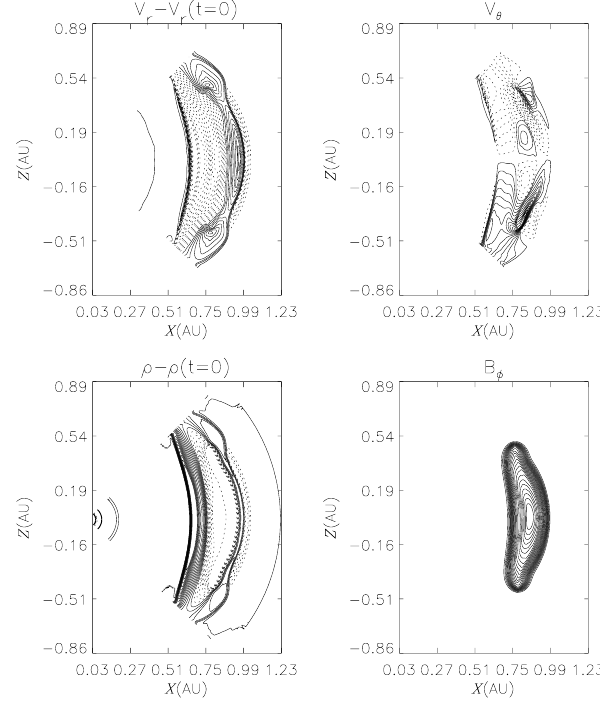
Fig. 7. As Fig. 4, except that the initial ICME speed is now 0.5 times that of the solar wind. The results are shown 3.29 days after onset. The maximum (minimum) contour values are 23 ( − 41)km/s, 17 ( − 17)km/s, 30% ( − 80%) and 9.88 (0)nT,